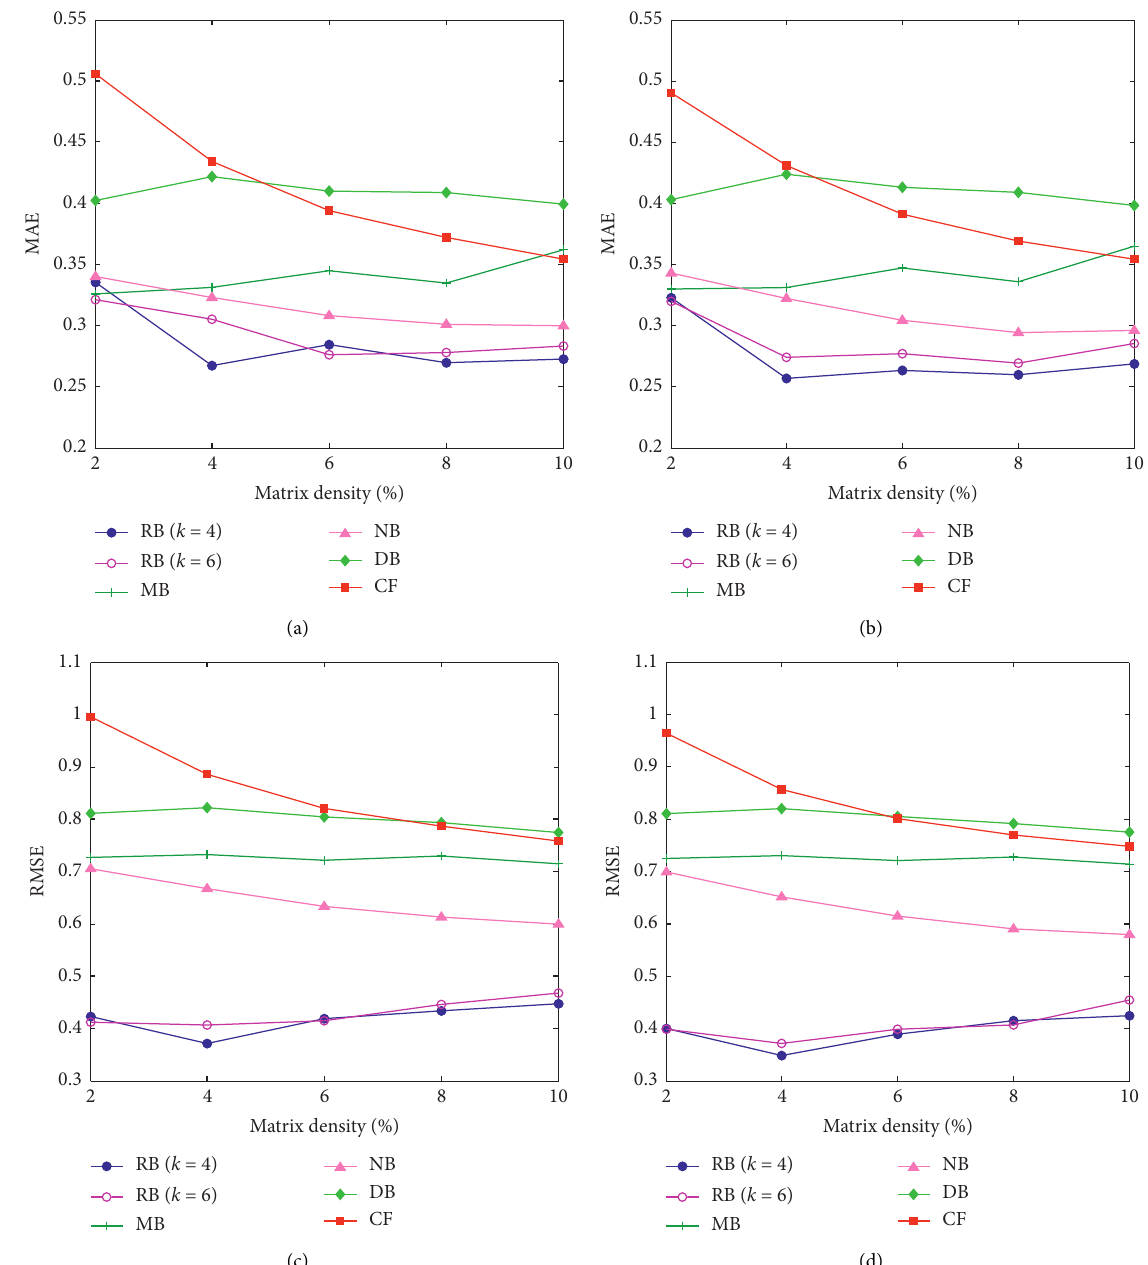
Figure 3: MAEs and RMSEs for different matrix densities (2%–10%). (a) MAE (number of neighbors: 15), (b) MAE (number of neighbors: 20), (c) RMSE (number of neighbors: 15), and (d) RMSE (number of neighbors: